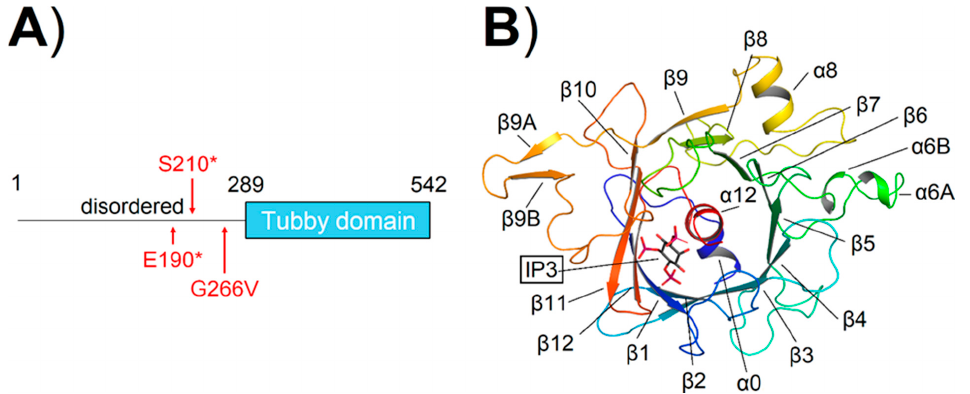
study residing outside of the Tubby domain are indicated by red arrows. ( B ) Three-dimensional structure of IP 3 -bound TULP1. Protein structure is displayed as cartoons in a blue-to-red color scheme according to the sequence, secondary structure elements are labeled, and IP 3 is framed and represented as sticks with C atoms in black, P atoms in violet, and O atoms in